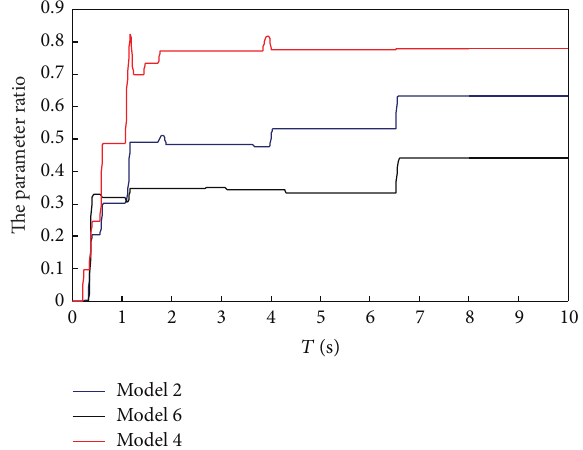
Figure 27: The parameter ratio of pier between windows and spandrel under Lixian County ground motion.